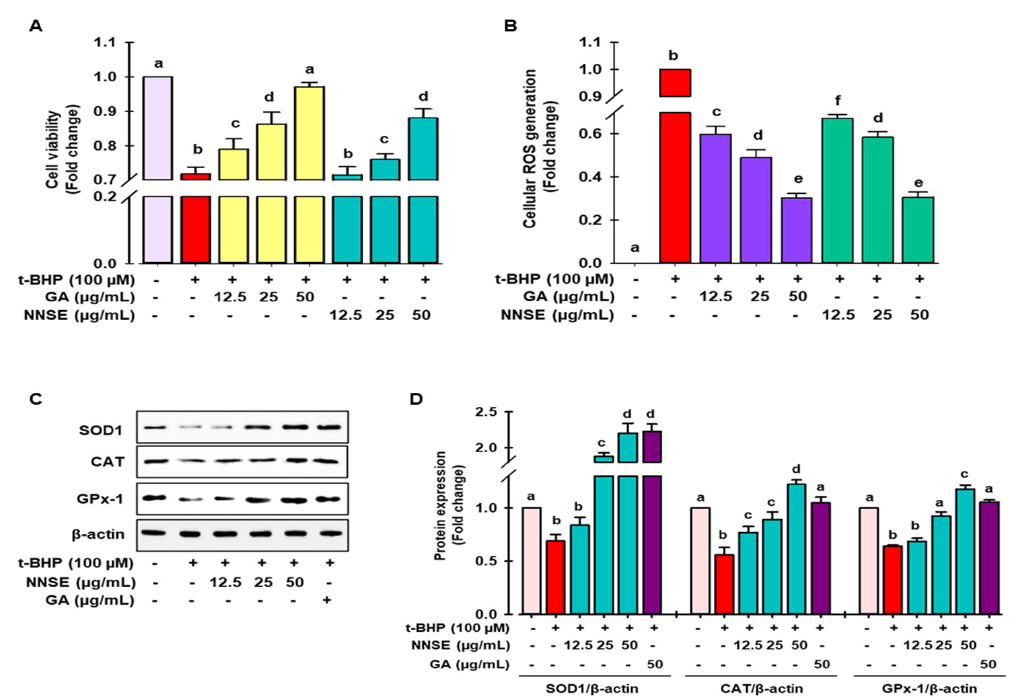
Figure 5. Attenuation of t -BHP-induced cell toxicity and intracellular ROS generation by NNSE and upregulation of antioxidant enzymes. Pretreatment of cells with NNSE and gallic acid for 12 h followed by treatment with 100 µM t-BHP for 6 h. The viable cells were counted, and the generation of cellular ROS was evaluated by ( A ) MTT assay and ( B ) DCFH-DA method, respectively. ( C ) Protein expression of SOD1, catalase, and GPx-1 was measured by western blot analysis. ( D ) The relative protein expression was quantified by Image J software. Values are expressed as the mean ± SD ( n = 3), and different letters are considered statistically significant ( p < 0.05) to one another. GA, gallic acid. The different color represents the model control, positive control, and samples in each experiment.